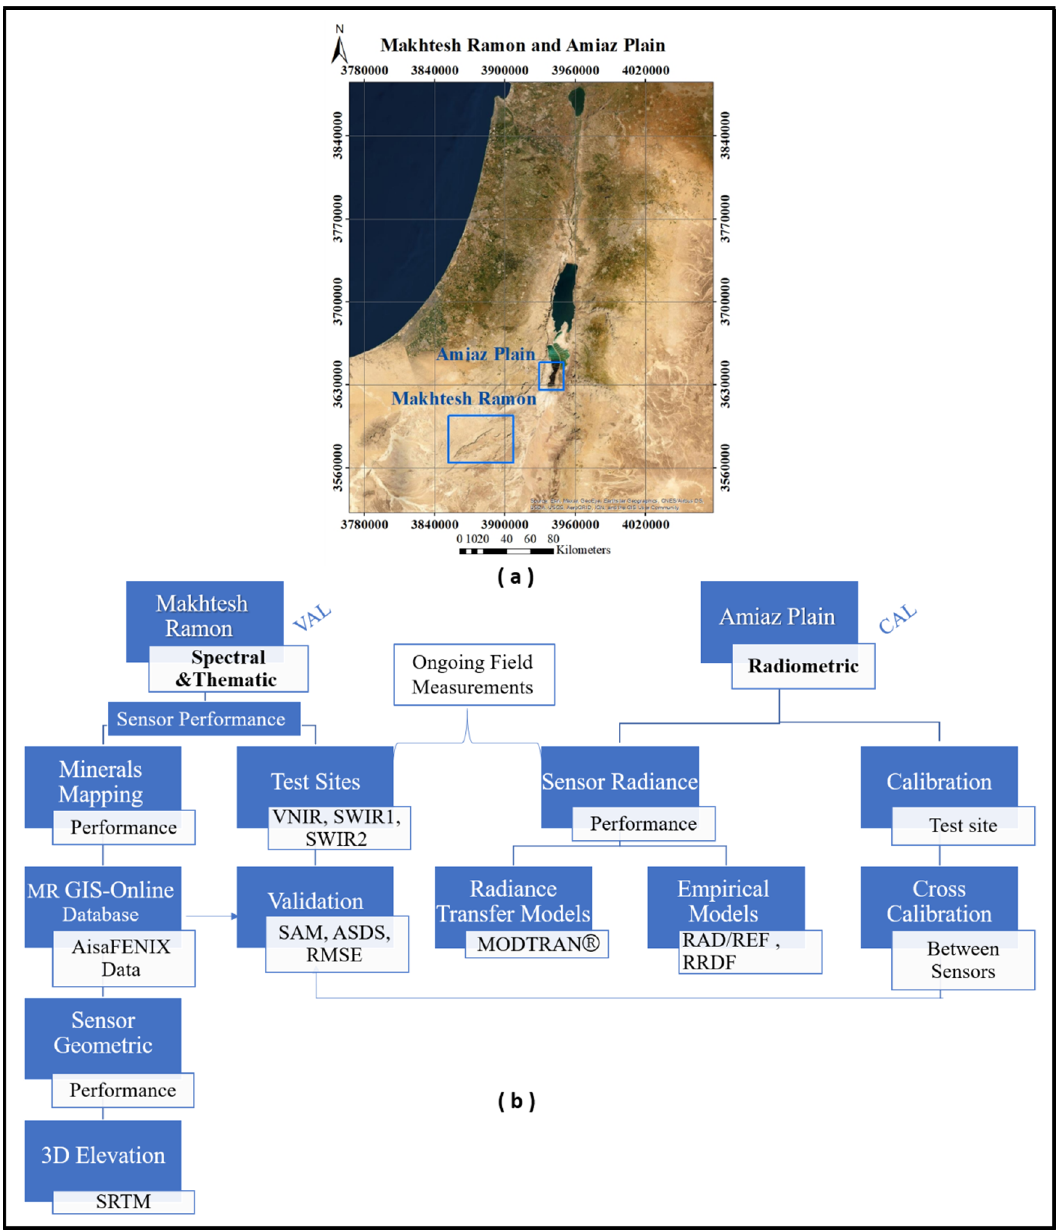
Figure 1. Amiaz Plain (AP) and Makhtesh Ramon (MR) calibration/validation (CAL/VAL) test sites. ( a ) AP and MR locations in Israel. ( b ) Work protocol flowchart .